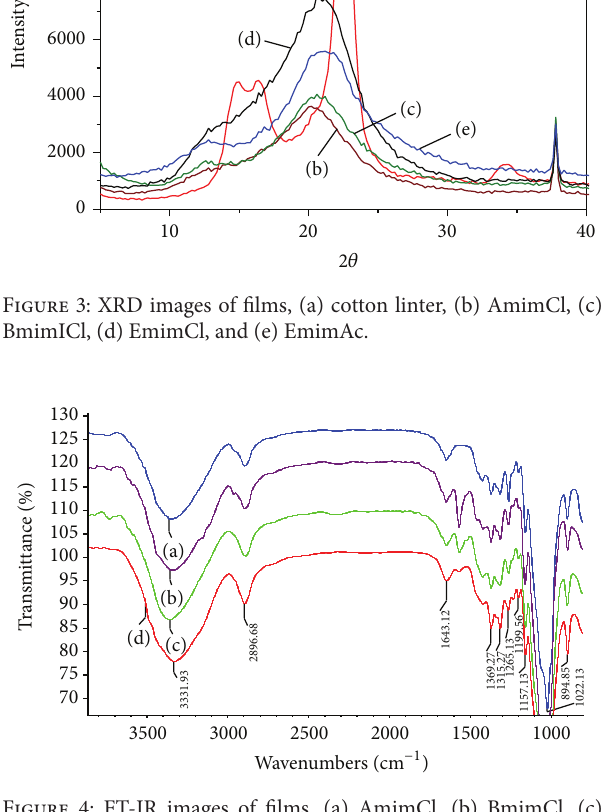
Figure 4: FT-IR images of films, (a) AmimCl, (b) BmimCl, (c) EmimCl, and (d) EmimAc.